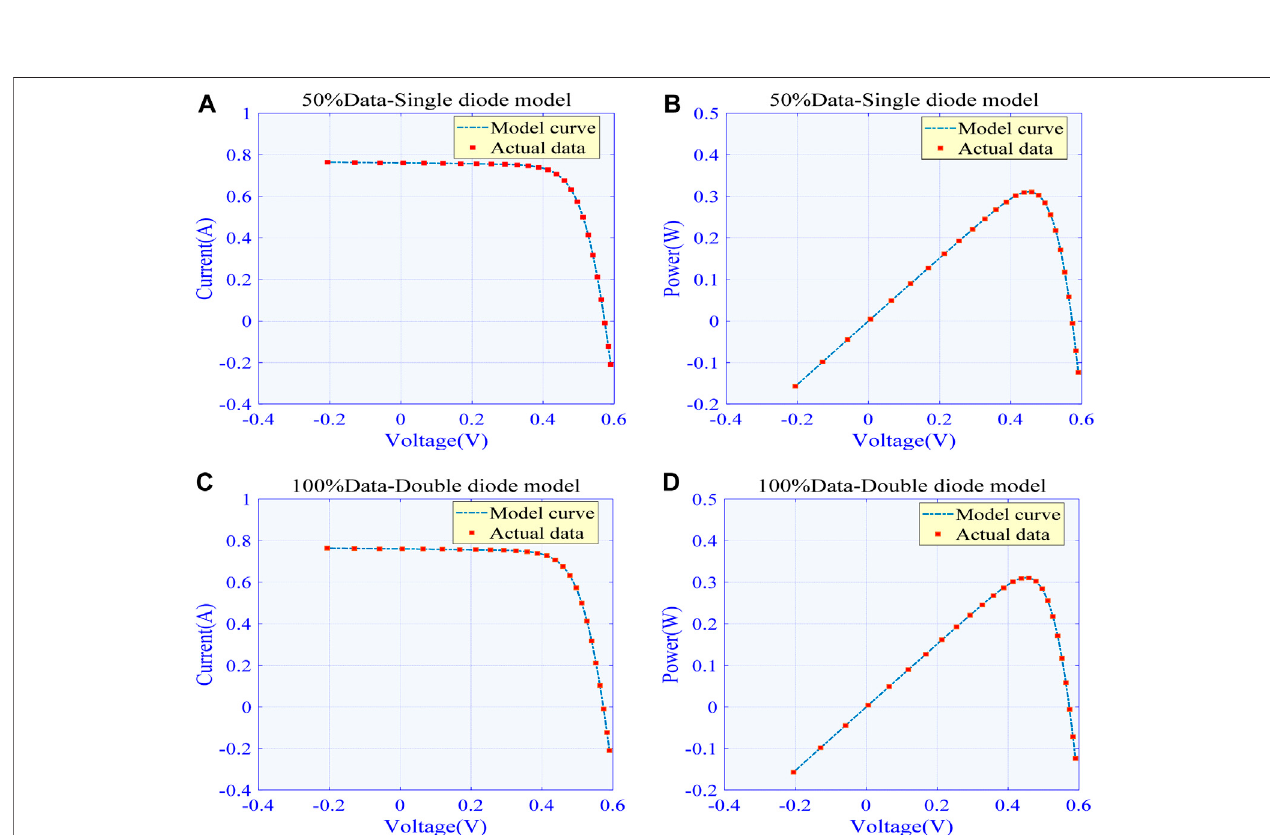
FIGURE 5 | Comparison between actual data and model curve obtained by the best algorithm in different training data for SDM: (A) I-V curve in 50% training data (B) P-V curve in 50% training data (C) I-V curve in 100% training data and (D) I-V curve in 100% training data.